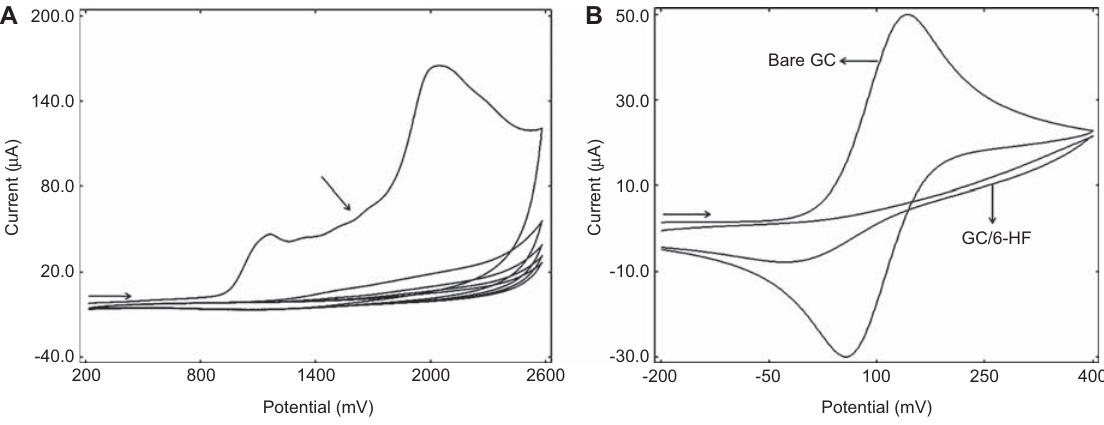
Figure 4 (A) Cyclic voltammogram of 1 m m 6-HF in 0.1 m TBATFB, + 0.2 V and + 2.6 V potential range using 100 mV s -1 with fi ve cycles; (B) surface characterization with